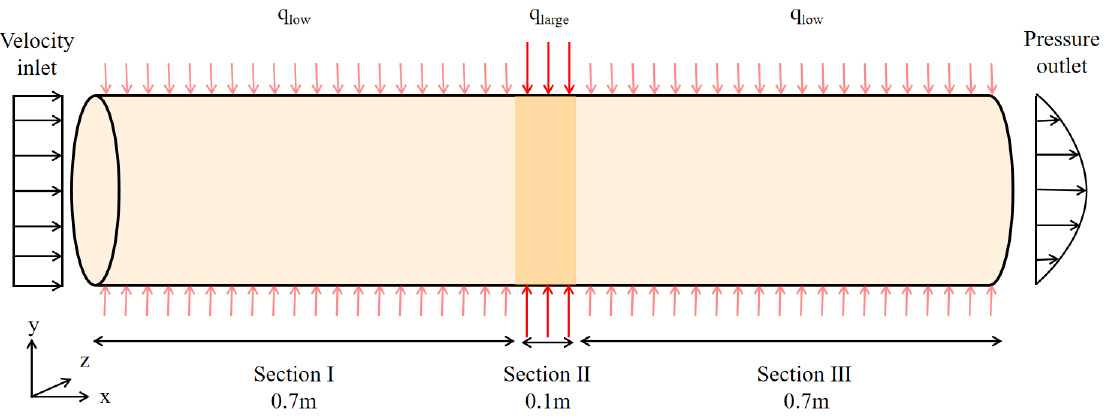
Figure 1. Schematic diagram of the flow configuration with relevant notations and boundary con- ditions.